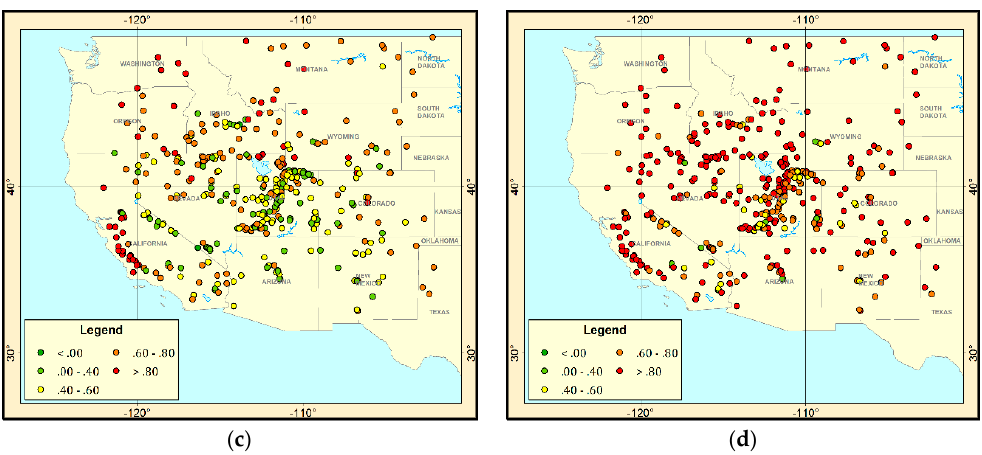
Figure 4. Spatial distribution of R between the site-specific SSM and original ( a , c ) and fused ( b , d ) SMAP SSM over each station using “sm_sat-whole” ( a , b ) and “sm_sat-rcmd” ( c , d ).